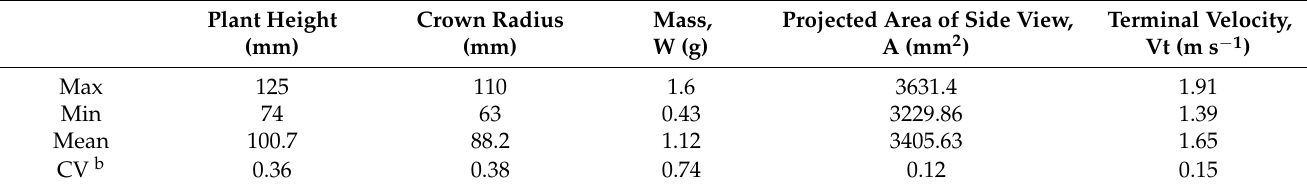
Table 1. Characteristics of the tomato seedlings a